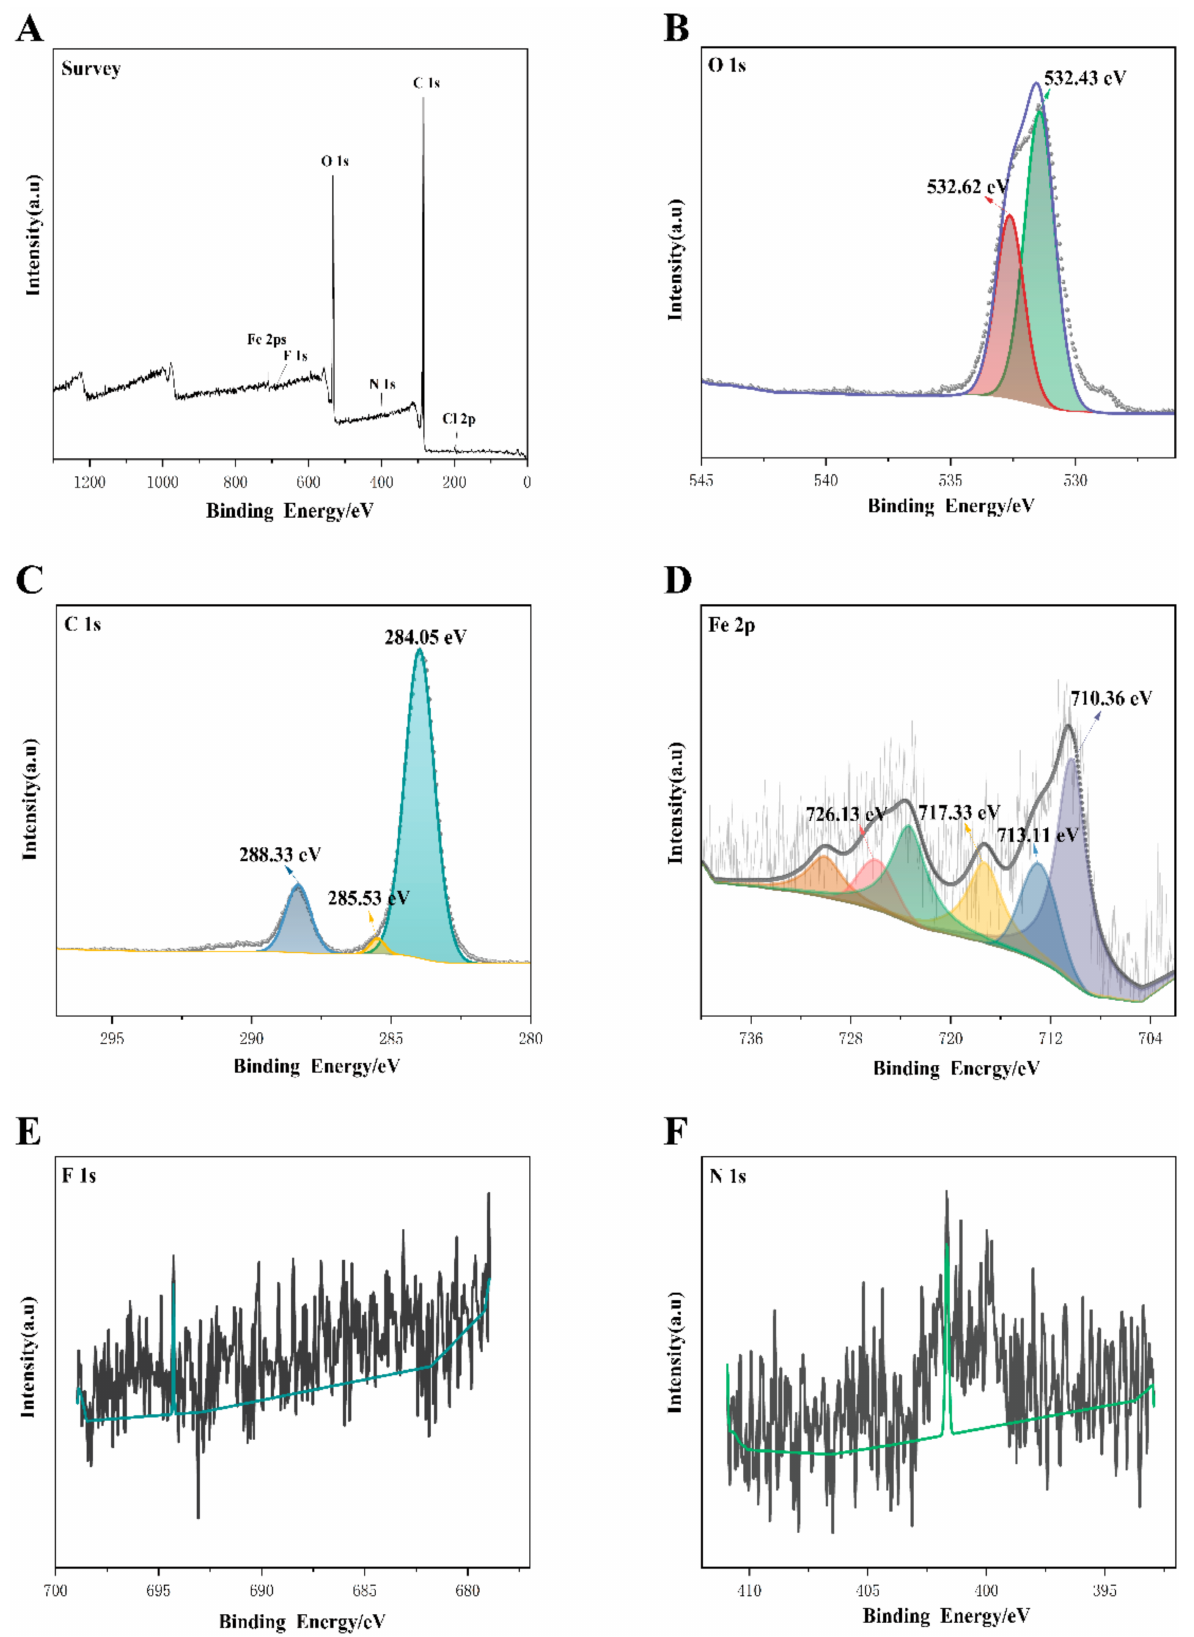
Figure 6. X-ray photoelectron spectroscopy spectra of MIL-101(Fe)-T705 ( A ) survey; ( B ) O 1s; ( C ) C 1s; ( D ) Fe 2p; ( E ) F 1s; ( F ) N